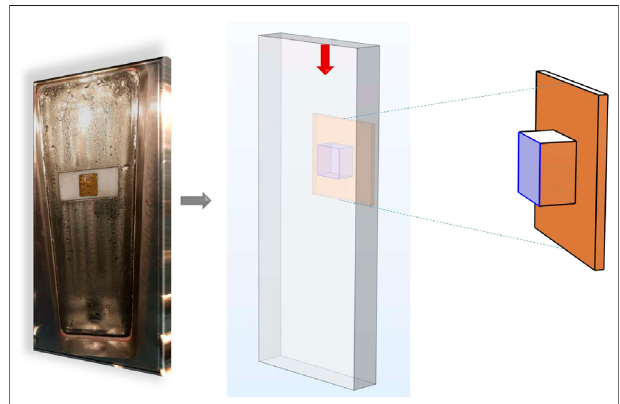
FIGURE 3 | Local simpli fi ed model of the condensation block and condensation